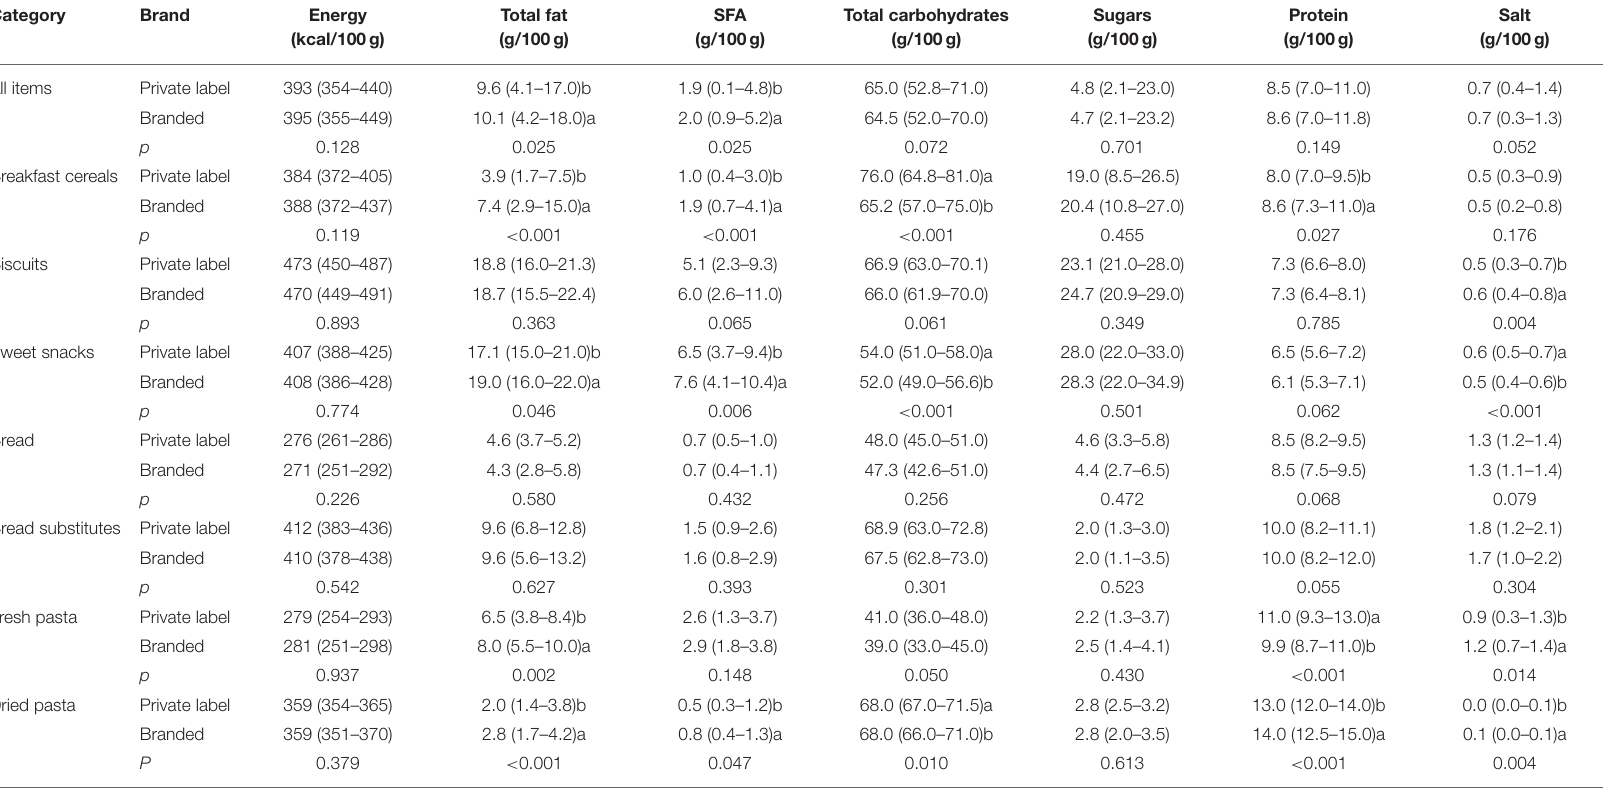
Values are expressed as median (25th − 75th percentile). Different lowercase letters indicate significant differences between PL and BR items belonging to the same category (Mann–Whitney non-parametric test for two independent samples), p < 0.05. SFA, saturated fatty